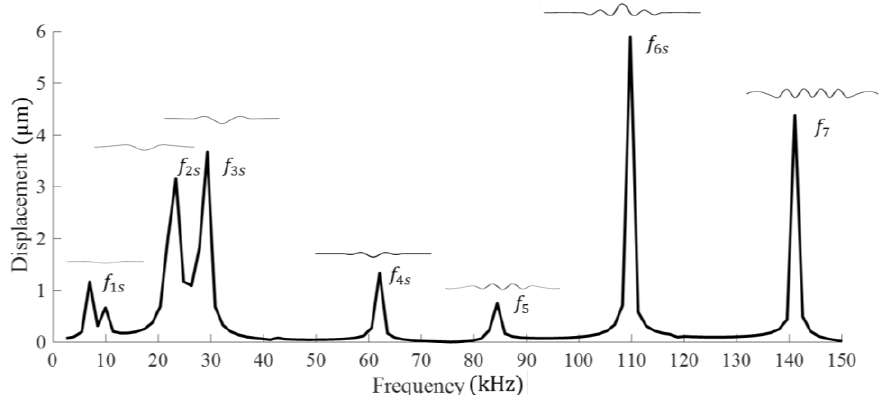
Figure 12. Numerical results of the frequency sweep for 20 V obtained by FEM. A schematic of the frequency mode cross-section is shown above every detected frequency.